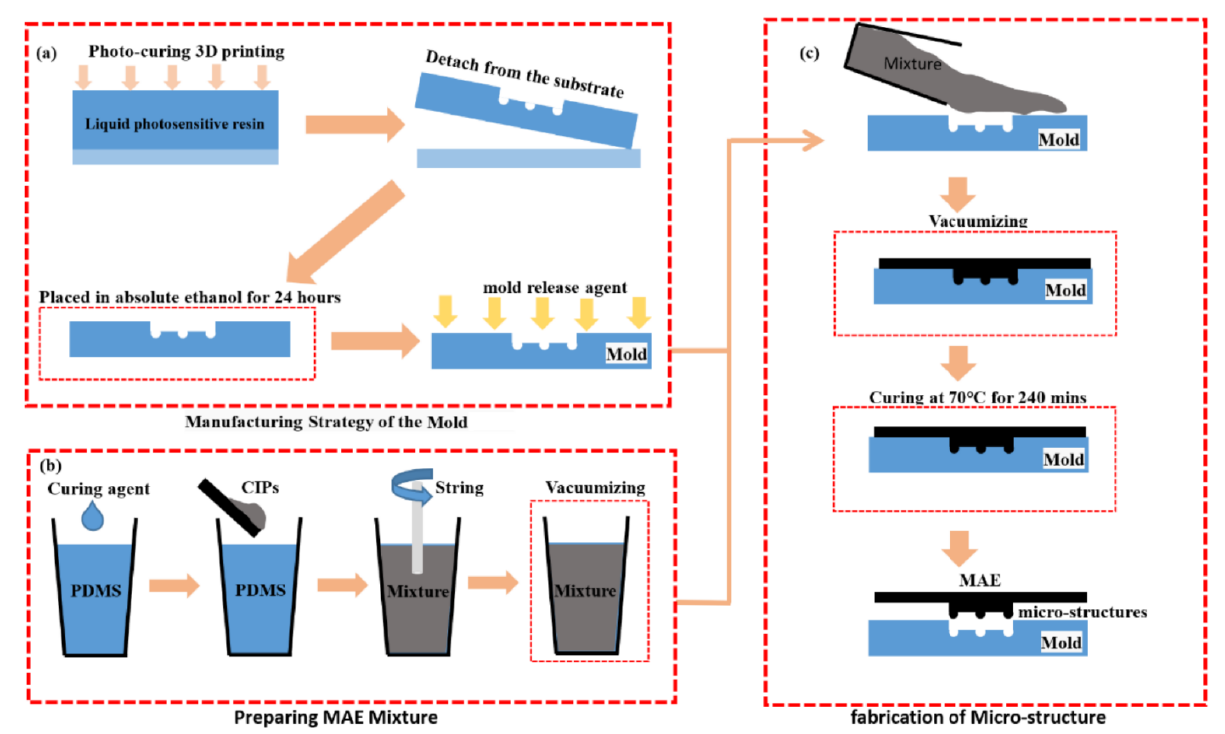
Figure 2. The fabrication strategy of the 2L-MAE ( a ) Manufacturing of the female mold ( b ) Preparation of the MAE mixture ( c ) Fabrication of the Biomimetic microstructures.